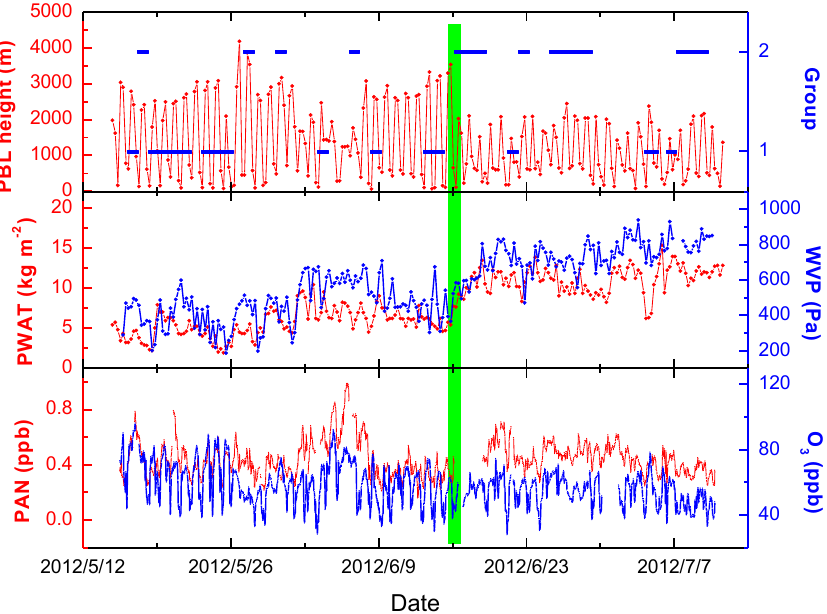
Figure 5. Distributions of two groups of days and time series the PBL height, PWAT (precipitable water of entire atmosphere), WVP (water vapor pressure), PAN and O 3 . Groups 1 and 2 represent two groups of days with different O 3 enhancement ( (cid:49) O 3 ) during 05:00–10:00LT, with Group 1 including 15 days with the greatest (cid:49) O 3 (denoted as High (cid:49) O 3 in Fig. 4) and Group 2 including 15 days with the smallest (cid:49) O 3 (denoted as Low (cid:49) O 3 in Fig. 4). The PBL height and PWAT were acquired from the FNL data with temporal resolution of 6h. WVP were calculated and processed as 6h resolution data from field observations. PAN and O 3 concentrations were processed as hourly